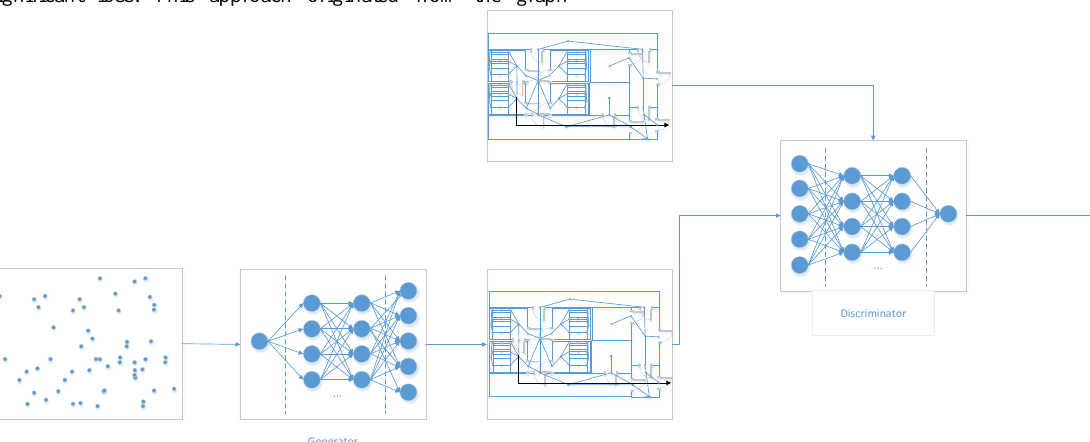
Figure 1. The demonstration of the GraphGAN for our approach